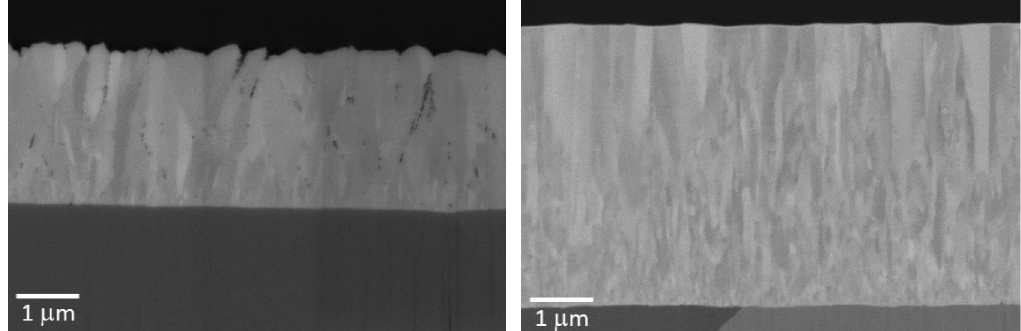
FIG. 3. FIB-SEM cross section images of HIE-ISOLDE coating at the top of the cavity with − 80 V bias (left) and − 120 V bias þ wide cathode (right) showing the densification of the layer.